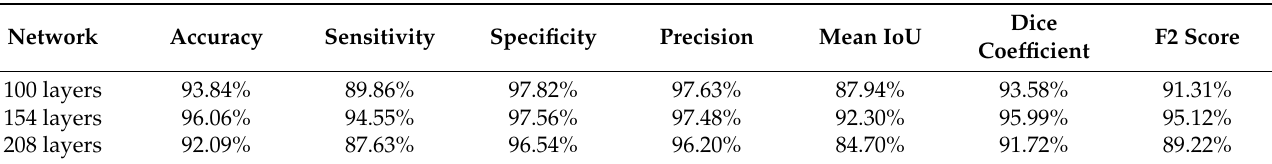
Table 3. Polyp segmentation results from the testing dataset, for modified SegNet models with three different numbers of layers.